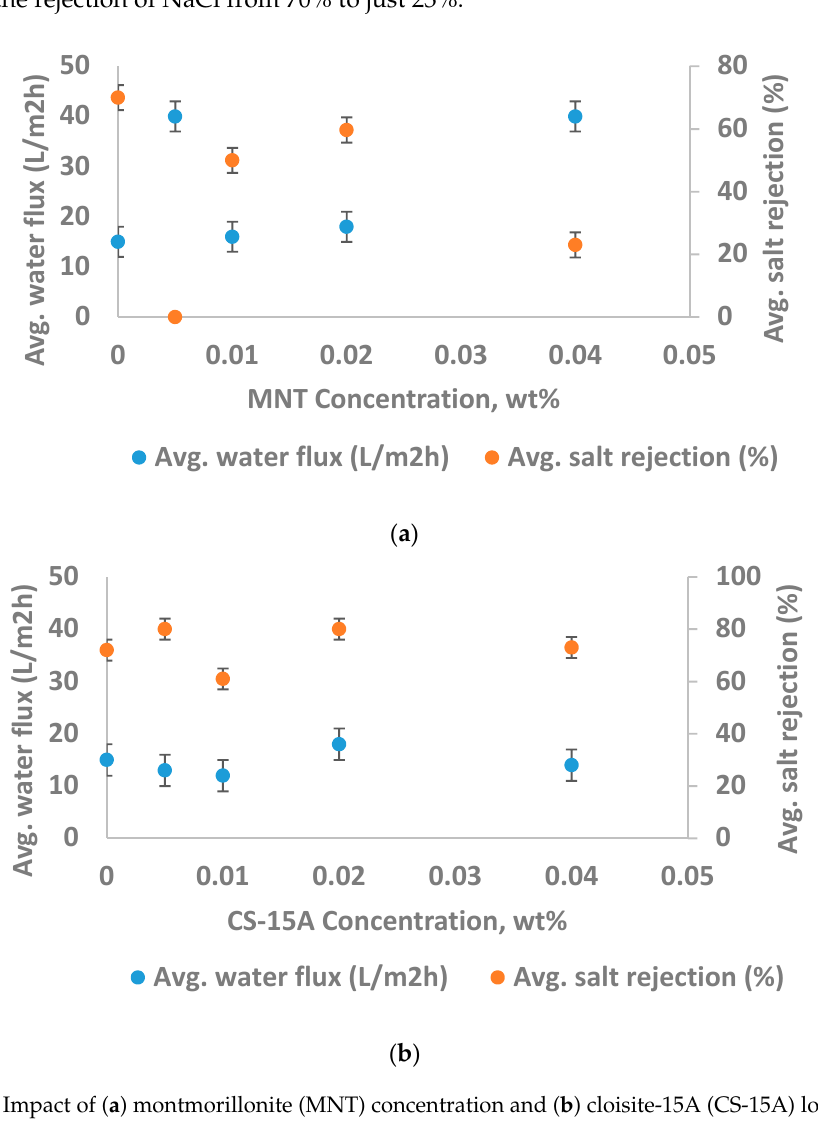
Figure 7. Cross-section transmission electron microscopy image of MNT ( a ) and CS-15A ( b ) modified PA membranes (0.04 wt.% MNT).